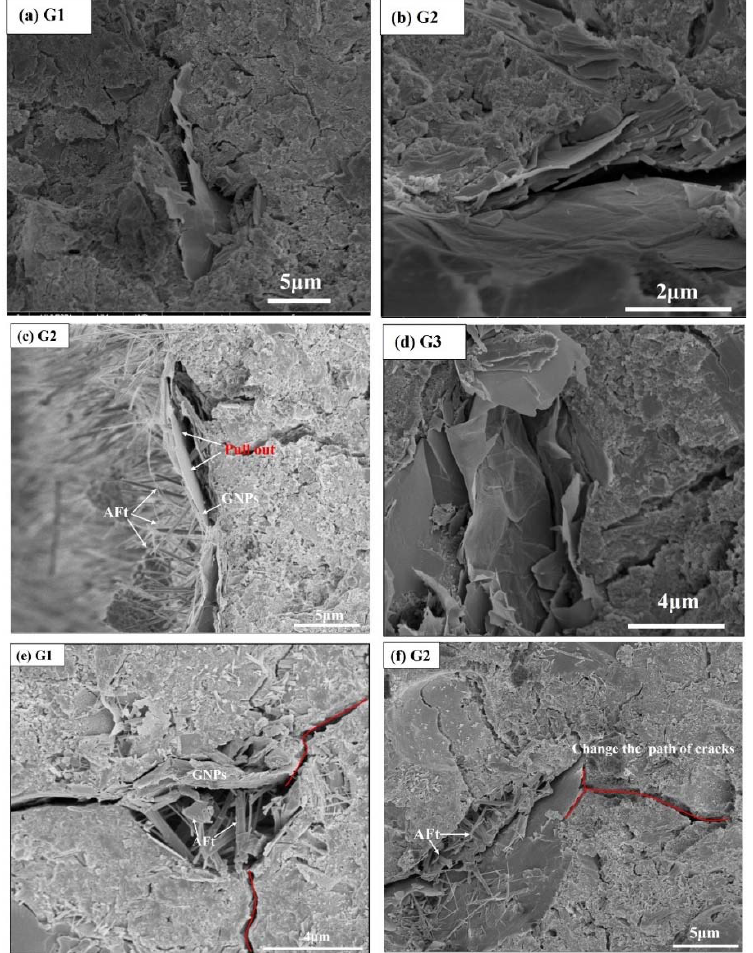
Figure 11. Morphology of GNPs in sulfoaluminate cement paste.